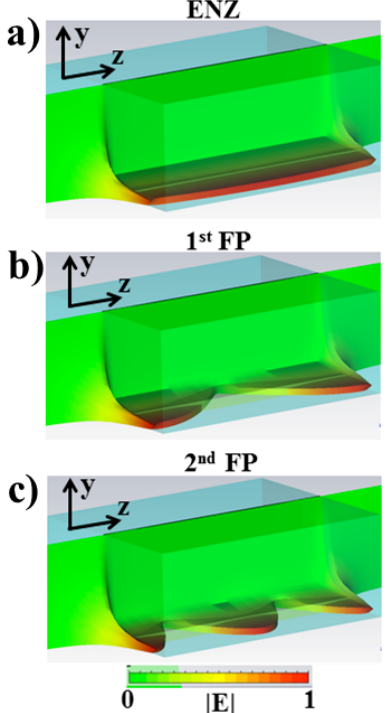
Figure 4: The electric field distributions are computed inside the narrow rectangular apertures at the a) ENZ operation and at the b) 1 st FP and c) 2 nd FP frequency resonances. Homogeneous and highly confined fields are obtained at the ENZ frequency (a), on the contrary standing wave field patterns are observed at the first (b) and second (c) FP frequencies.